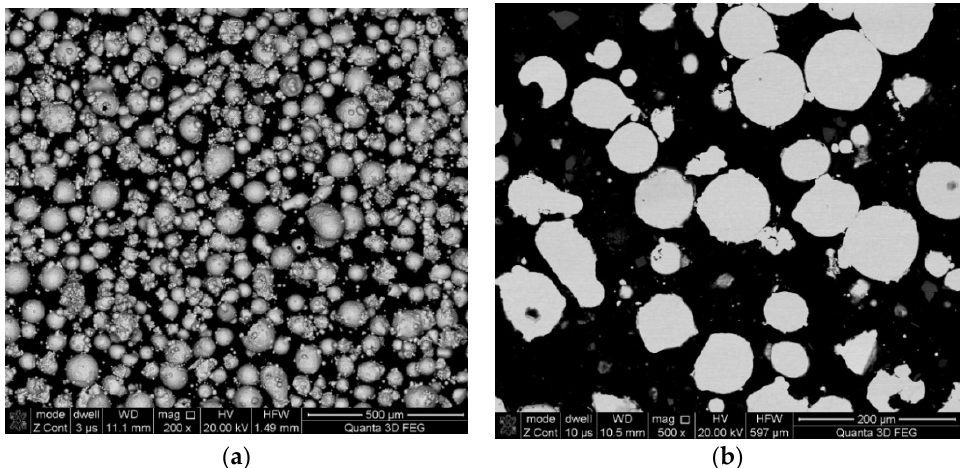
Figure 1. M300 maraging steel powder ( a ) morphology of the particles (SEM); ( b ) metallographic cross-section.